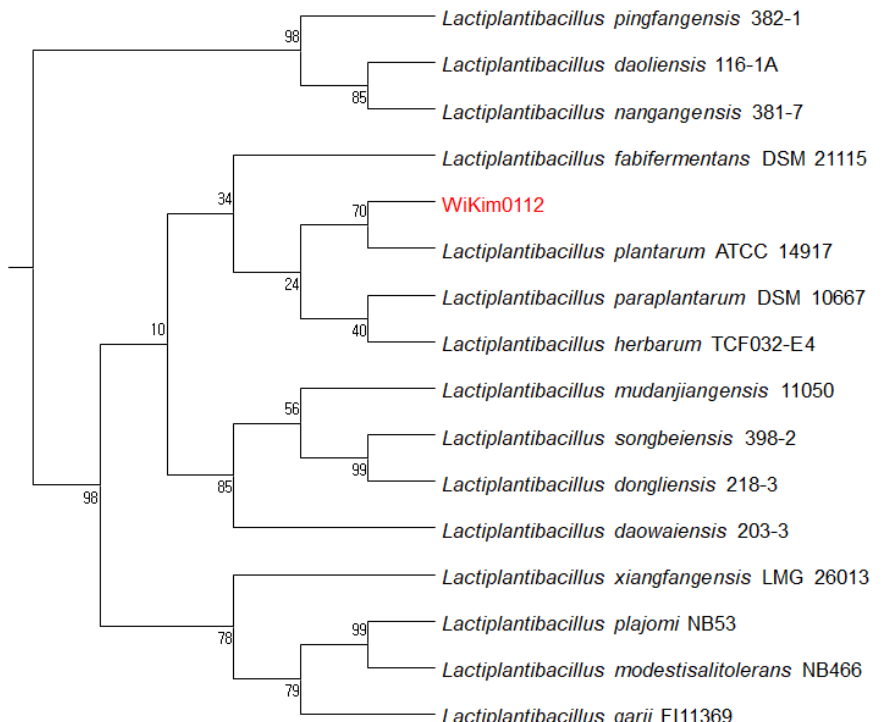
Figure 1. Phylogenetic tree constructed using neighbor-joining based on 16S rRNA gene sequences of WiKim0112. Bootstrap percentages for 1000 re-sampling are given.